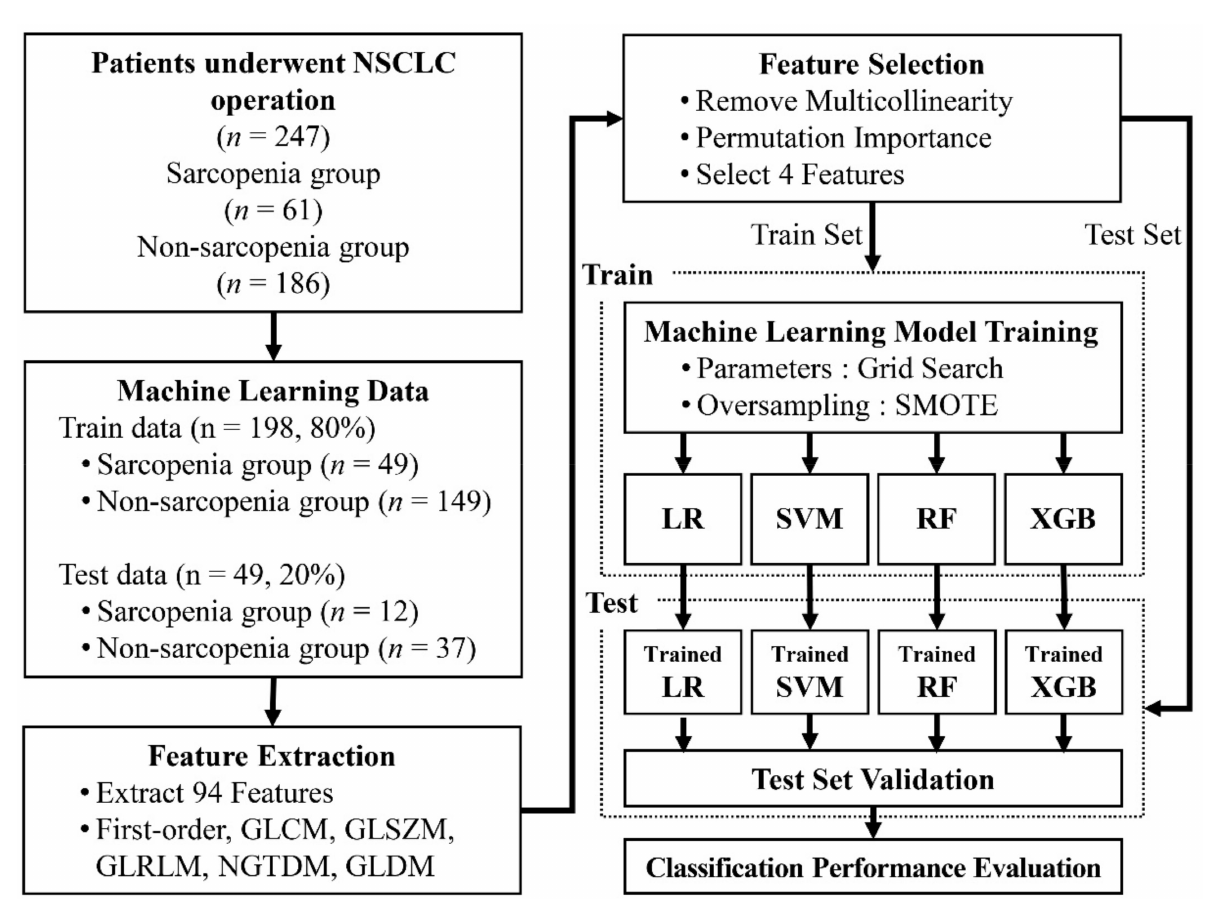
Figure 1. Flowchart of sarcopenia data collection and analysis. NSCLC, non-small cell lung carcinoma; GLCM, gray-level co-occurrence matrix; GLSZM, gray-level size zone matrix; GLRLM, gray-level run length matrix; NGTDM, neighboring gray-tone difference matrix; GLDM, gray-level dependence matrix; SMOTE, synthetic minority oversampling technique; LR, logistic regression; SVM, support vector machine; RF, random forest; XGB, extreme gradient